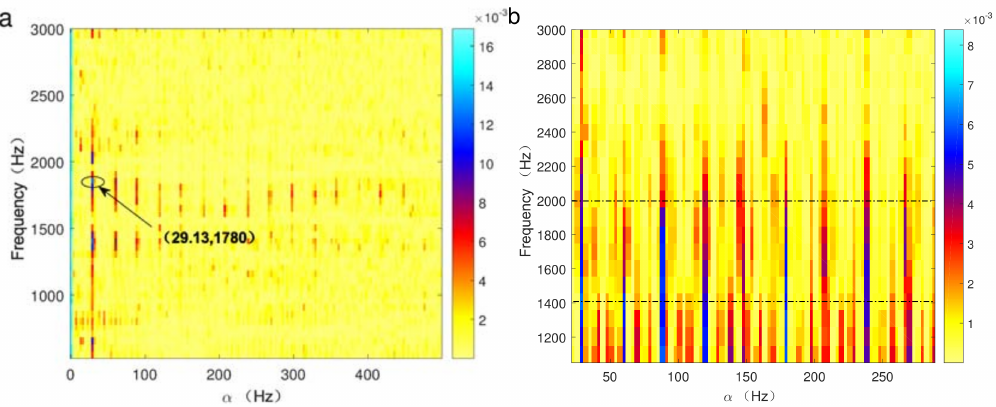
Figure 21. The MID SCoh ∆